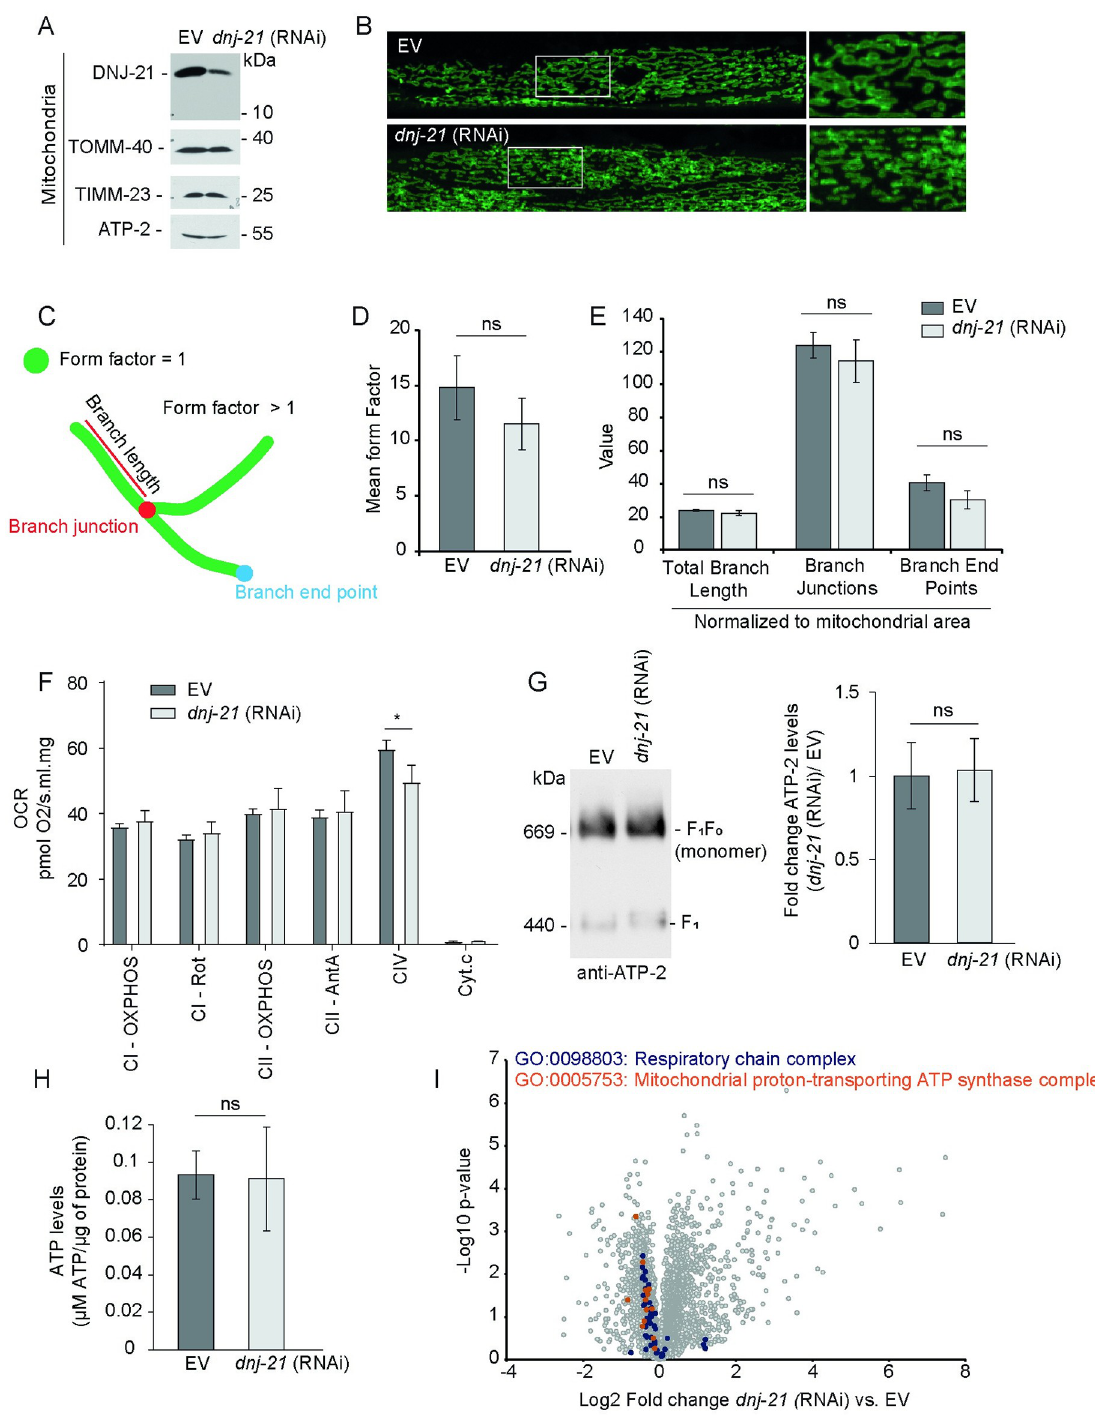
Fig 1. Depletion of mitochondrial import component results in mild mitochondrial stress. (A, F, G) Mitochondria were isolated from wild-type worms that were grown on RNAi bacteria from the embryonic stage to young adulthood. (A) Protein content was analyzed using SDS-PAGE and western blot in at least 2 biological replicates. (B) Worms were cultured on plates until they developed into young adults. Confocal images of C . elegans that expressed GFP targeted to the mitochondrial outer membrane in the body wall muscle (ACH89) are shown. A magnification of the white rectangle is shown in the right panel. (C) Schema of features that were analyzed to quantify mitochondrial morphology. Depicted features are according to the applied analysis tool “Mitoanalyzer.” Green shows possible shapes of